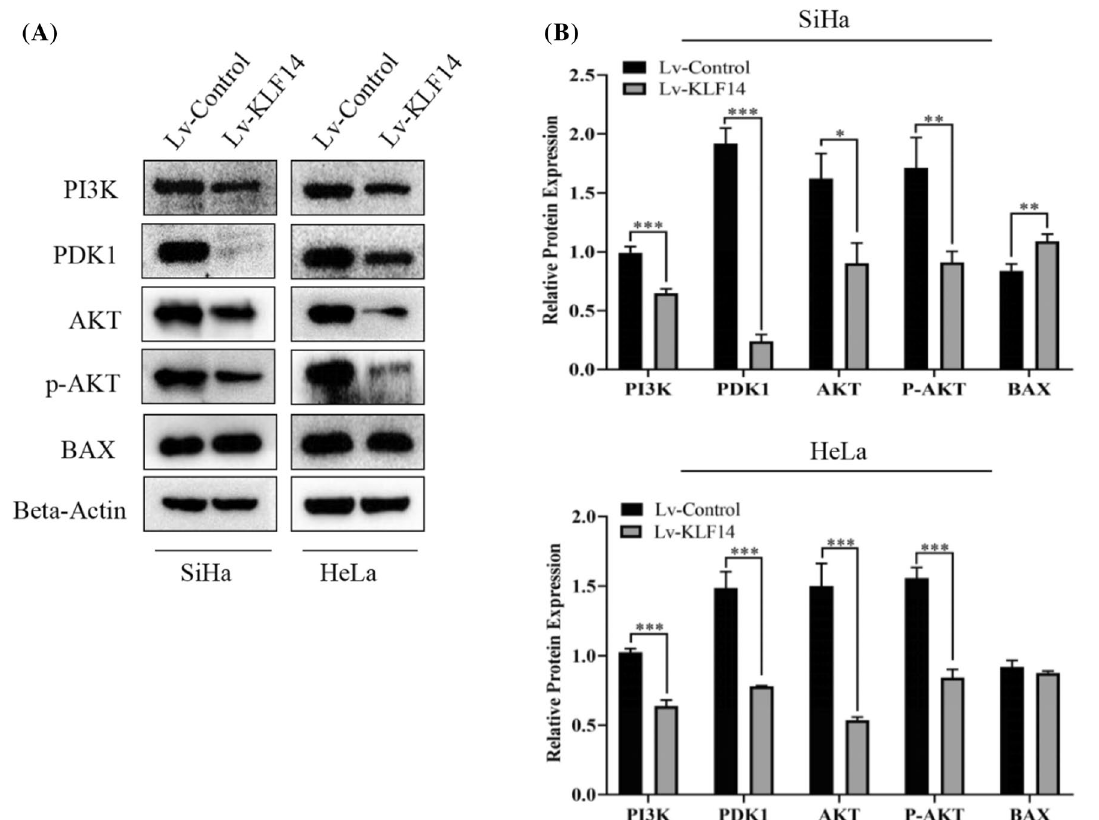
Fig. 6 KLF14 regulates related molecules in the PI3K/AKT signalling pathway. A When KLF14 was overexpressed, the Western blot results showed that PI3K, PDK1, AKT and p-AKT were downregulated and Bax was upregulated in SiHa cells compared to the Lv-control group cells. PI3K, PDK1, AKT and p-AKT were downregulated, and Bax showed no significant difference in HeLa cells compared to the Lv-control group cells. B Quantitative statistics of protein expression. (*P < 0.05, **P < 0.01, ***P <